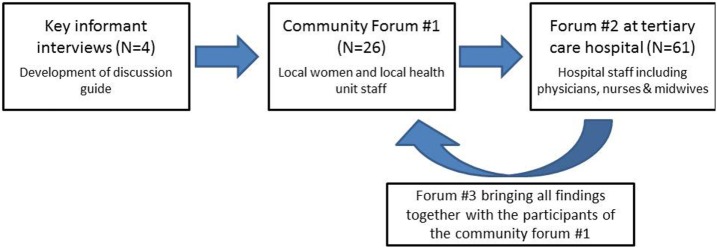
Study flow diagram.